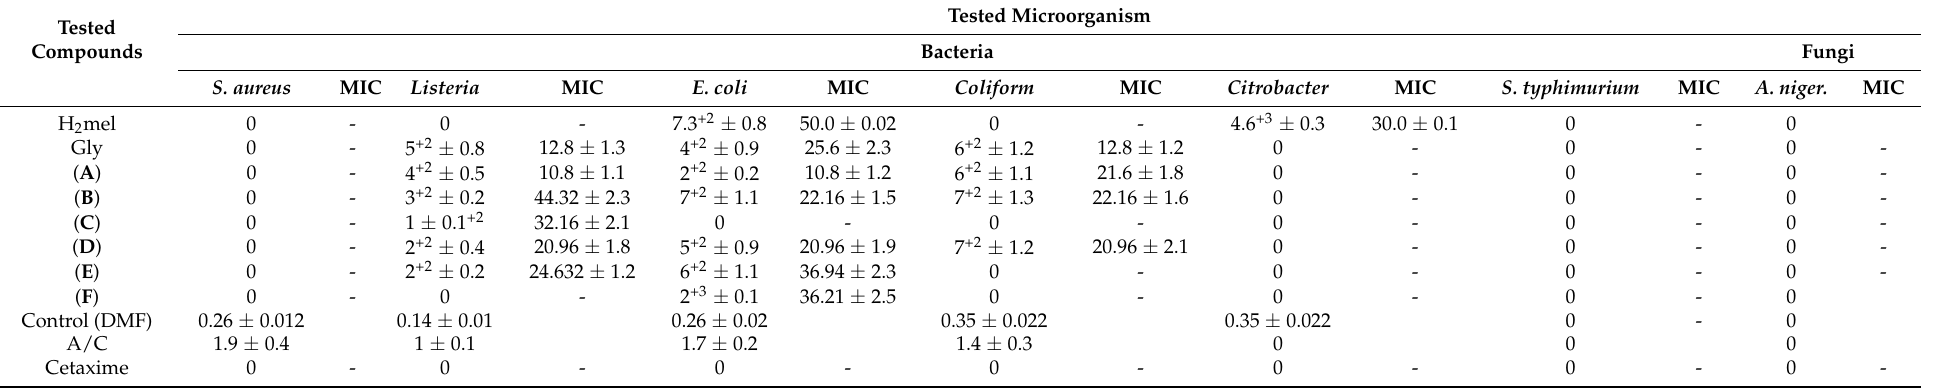
Table 5. The inhibition diameter zone (mm) and minimum inhibition concentration ( µ g/mL) values for H 2 mel, Gly and their metal complexes. Tested